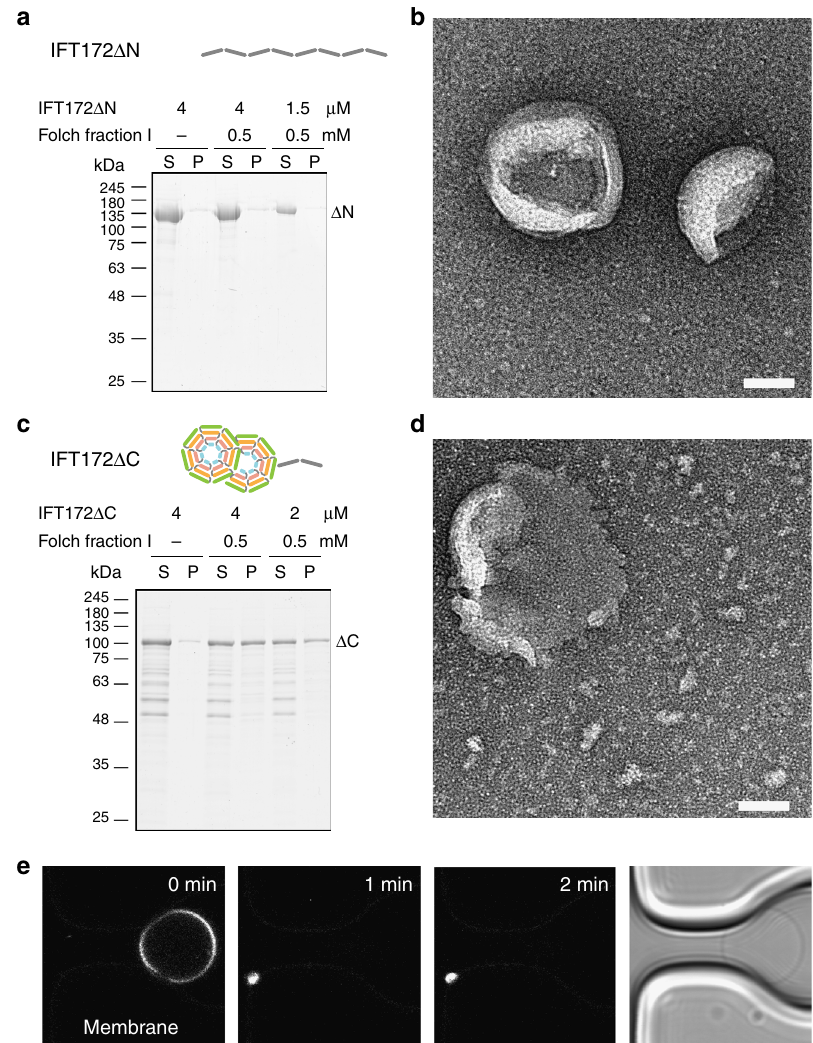
Fig. 6 Mapping of membrane-binding region in IFT172. a Co-sedimentation assay of IFT172 Δ N with Folch fraction I MLV. IFT172 Δ N shows no af fi nity to membranes. b Negative-stain EM images of IFT172 Δ N with Folch fraction I liposomes do not show remodeling of the membrane surface. Scale bar: 50 nm c Co-sedimentation assay of IFT172 Δ C with Folch fraction I MLV. IFT172 Δ C shows af fi nity to membranes. d Negative-stain EM images of IFT172 Δ C with Folch fraction I liposomes show the remodeling of the membrane surface. Scale bar: 50 nm. e Observation of the effect of IFT172 Δ C on GUVs. GUVs collapse after IFT172 Δ C